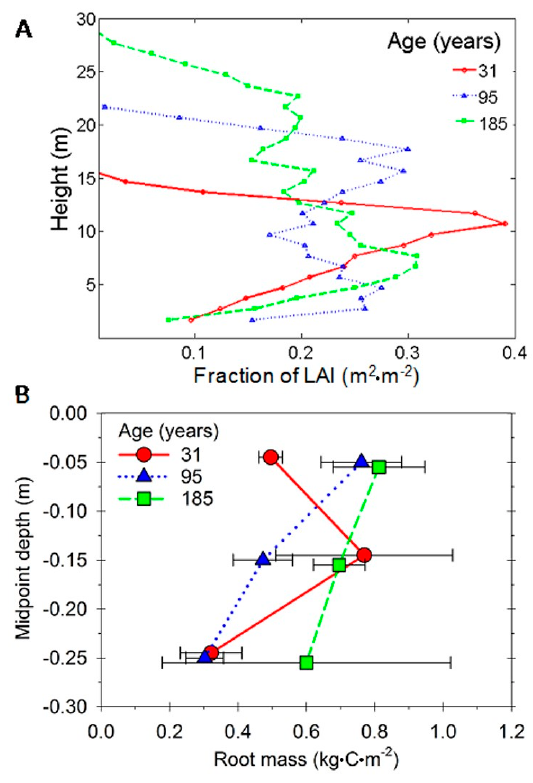
Figure 3. Canopy and root vertical profiles. Vertical profiles of canopy and root biomass change with stand age demonstrating greater vertical uniformity in older stands. Canopy height increases with stand age and biomass distribution becomes more uniform ( A ). Mean root biomass ( ± SE) increases in deeper soil horizons as stands age, but younger forests exhibit highest root biomass at moderate depths ( B ).